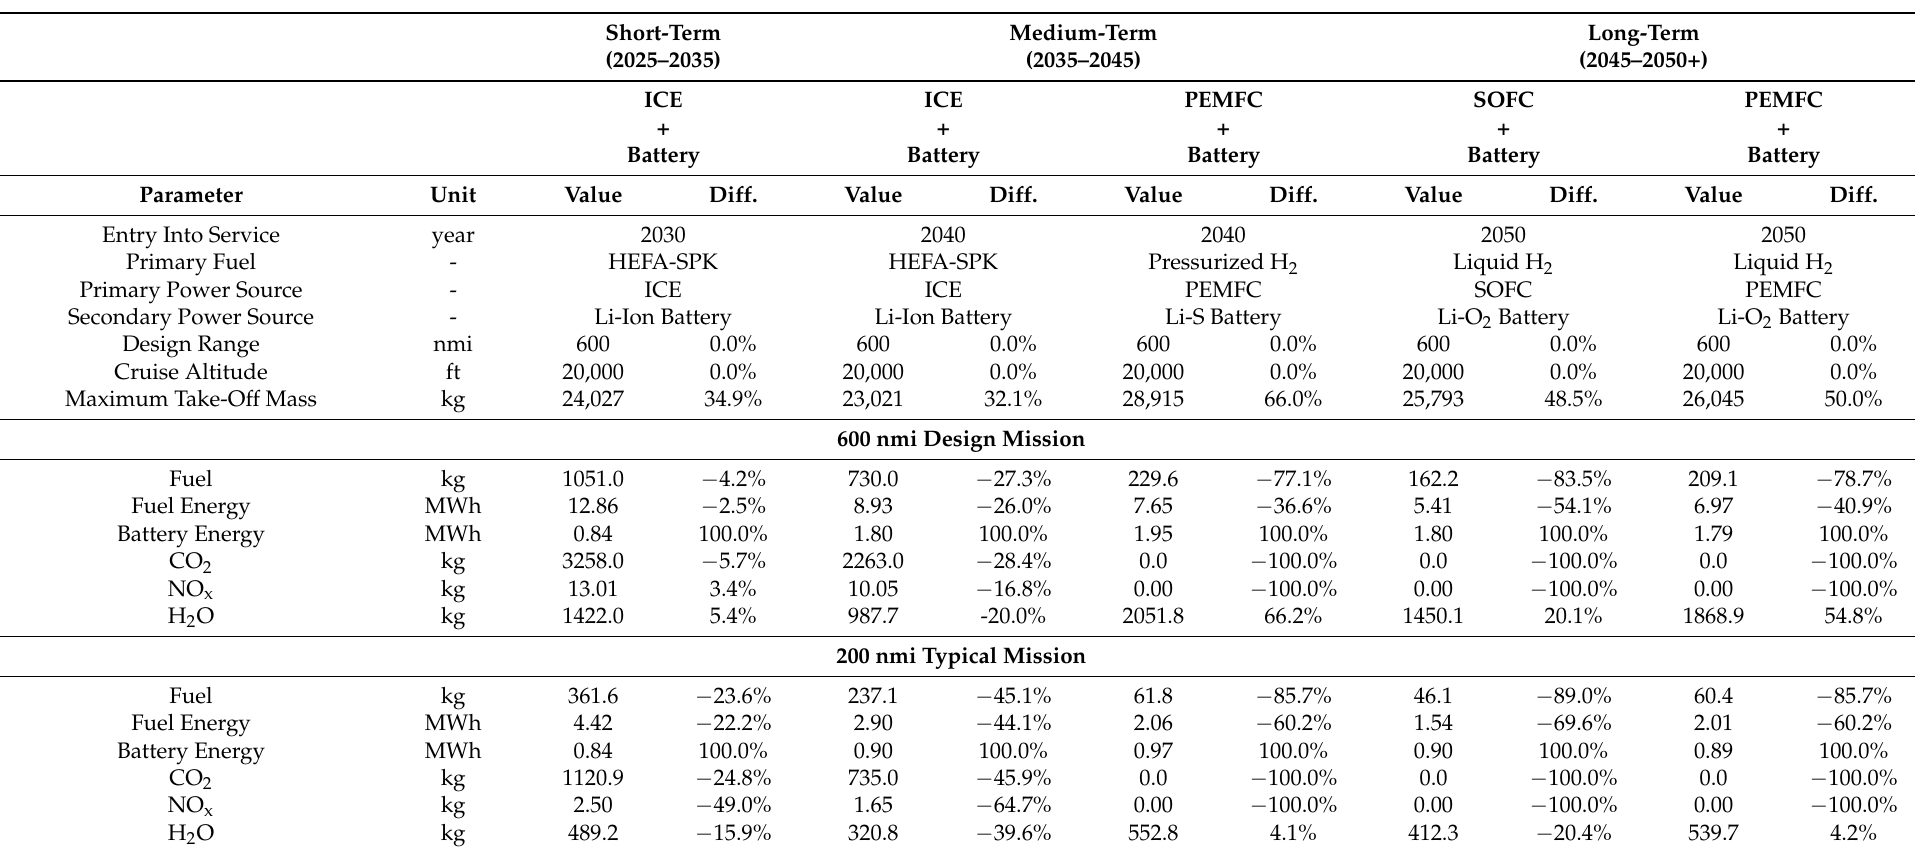
Table 11. Overview of the final future scenarios defined for the GENESIS project at different time horizons and using different powertrain configurations. Fuel and energy consumption, as well as pollutant emissions, are referred to the nominal block mission. Each configuration is compared to a reference conventional aircraft referred to the same entry-into-service year based on ICE and